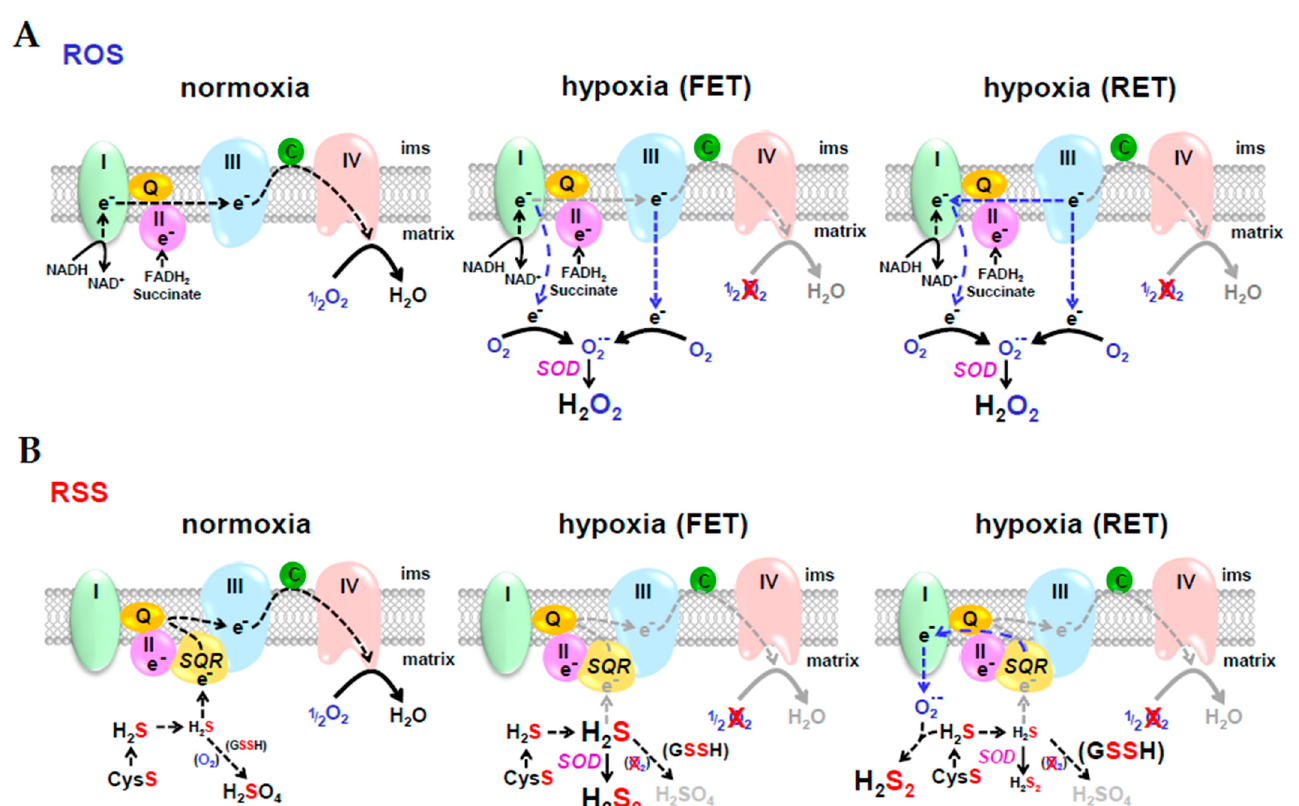
Figure 6. Reactive oxygen species (ROS) and reactive sulfur species (RSS) hypotheses for O 2 sensing. In the ROS hypothesis ( A ), hypoxia decreases forward electron transport (FET) down the electron transport chain and electrons leak from complexes I and III; in reverse electron transport (RET), electrons are delivered retrograde from complex III to complex I. As electrons leak from the complexes, they reduce O 2 to superoxide (O 2 •− ). Dismutation of superoxide, either spontaneously, or catalyzed by superoxide dismutase (SOD), produces hydrogen peroxide (H 2 O 2 ) which then diffuses out of the mitochondrion and oxidizes cysteine residues on the appropriate regulatory proteins. In the RSS hypothesis ( B ), hypoxia also decreases FET, but this decreases H 2 S oxidation by sulfide quinone oxidoreductase (SQR) thereby increasing mitochondrial H 2 S concentration. Excess H 2 S is oxidized by SOD, or by electrons from RET, to hydrogen persulfide H 2 S 2 which diffuses out of the mitochondrion and persulfidates cysteine residues on the appropriate regulatory proteins.